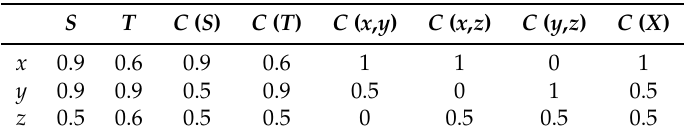
Table 1. The choice function and feasible subsets in Example 1. We omit brackets for simplicity.